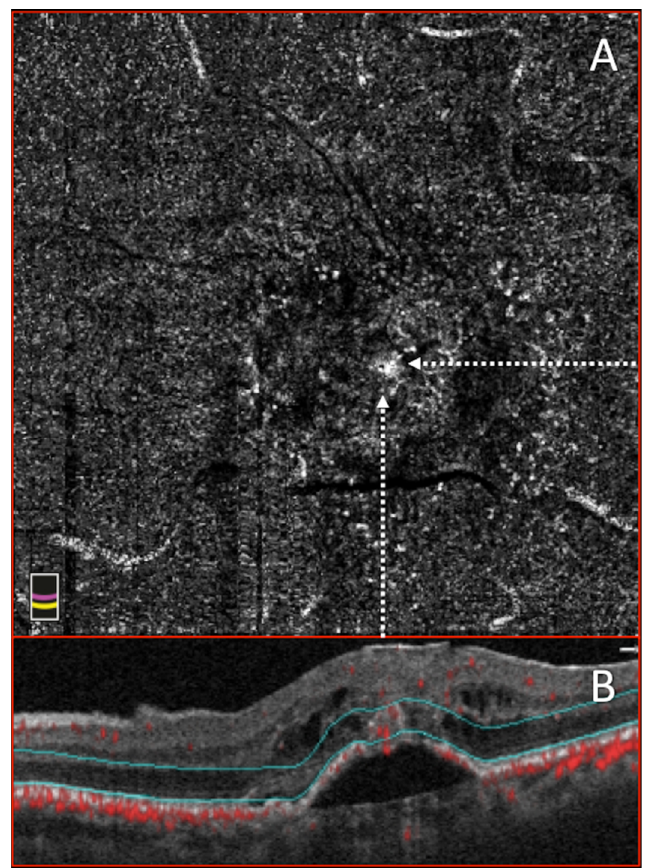
Figure 3. Optical Coherence tomography angiography (OCTA) and structural optical coherence tomography (OCT) of a Type III macular MNV. ( A ) 3 × 3 OCTA of outer retinal segment showing the presence of a white “point like” that corresponds to a detectable flow. ( B ) Co-registered structural OCT scan with hyporeflective cyst and hyperreflective intraretinal lesion.